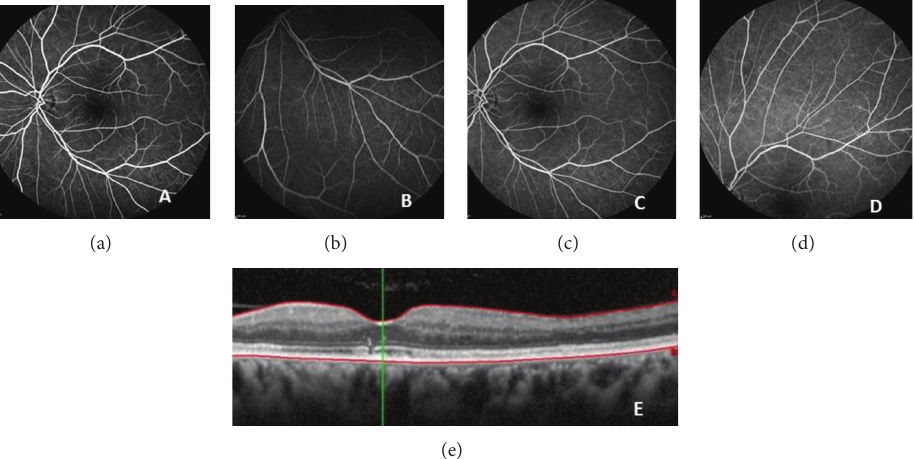
Figure 4: Fluorescein angiography ((a), (b), (c), and (d)) after one year showing complete resolution of retinal vasculitis and CRVO and OCT image (e) demonstrating resolution of detachment of the neurosensory